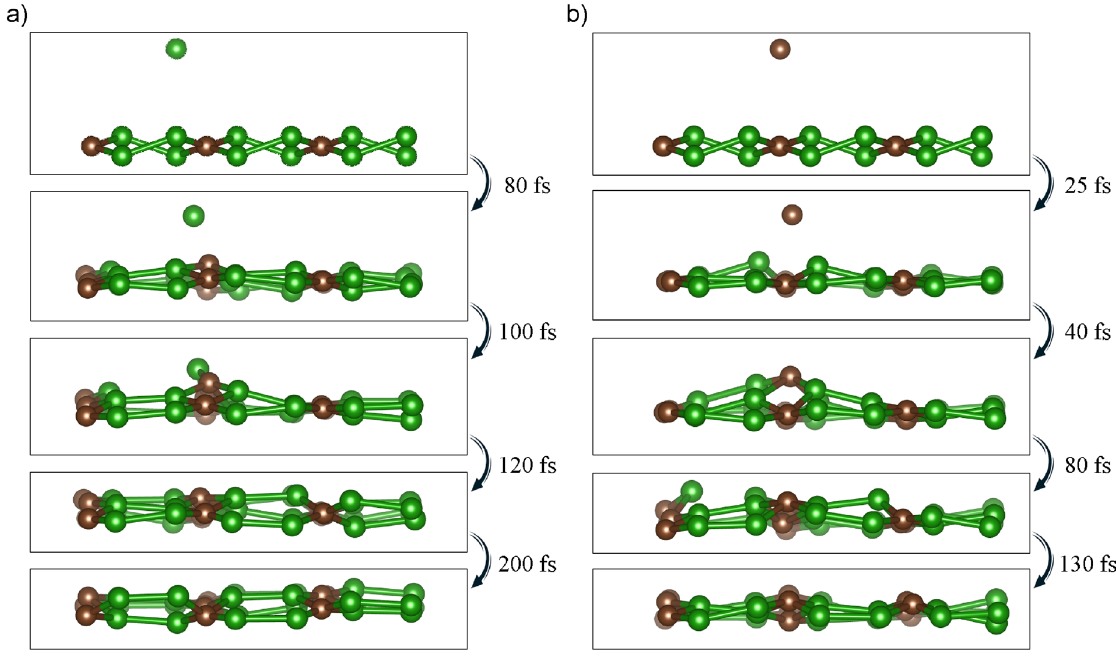
Figure 7. Spontaneous self-healing of B 2 C monolayer without any external stimulus at 300 K. The point defect was introduced by extracting the one boron atom ( a ) or one carbon atom ( b ) from the surface of the material to a distance of 2.7